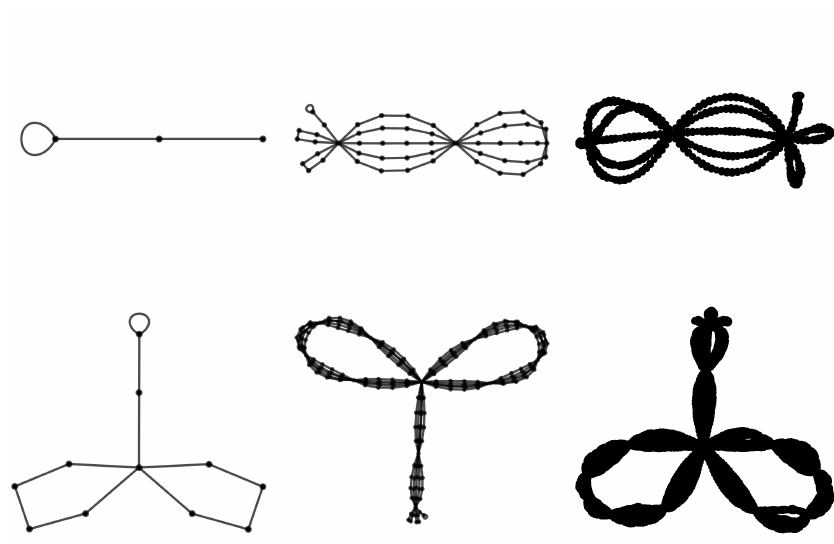
Figure 17. The A 5 n family of graphs. The top row shows the n odd subfamily for n = 1,3,5 and the bottom row shows the n even subfamily for n = 2,4,6.